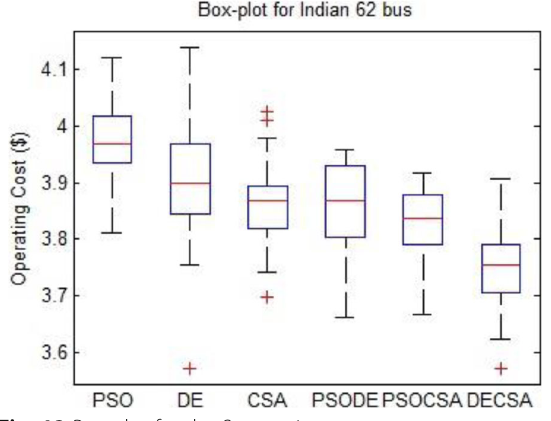
Fig. 12 Box plot for the System 1 Table 16 Wilcoxon signed rank test for statistical analysis Test